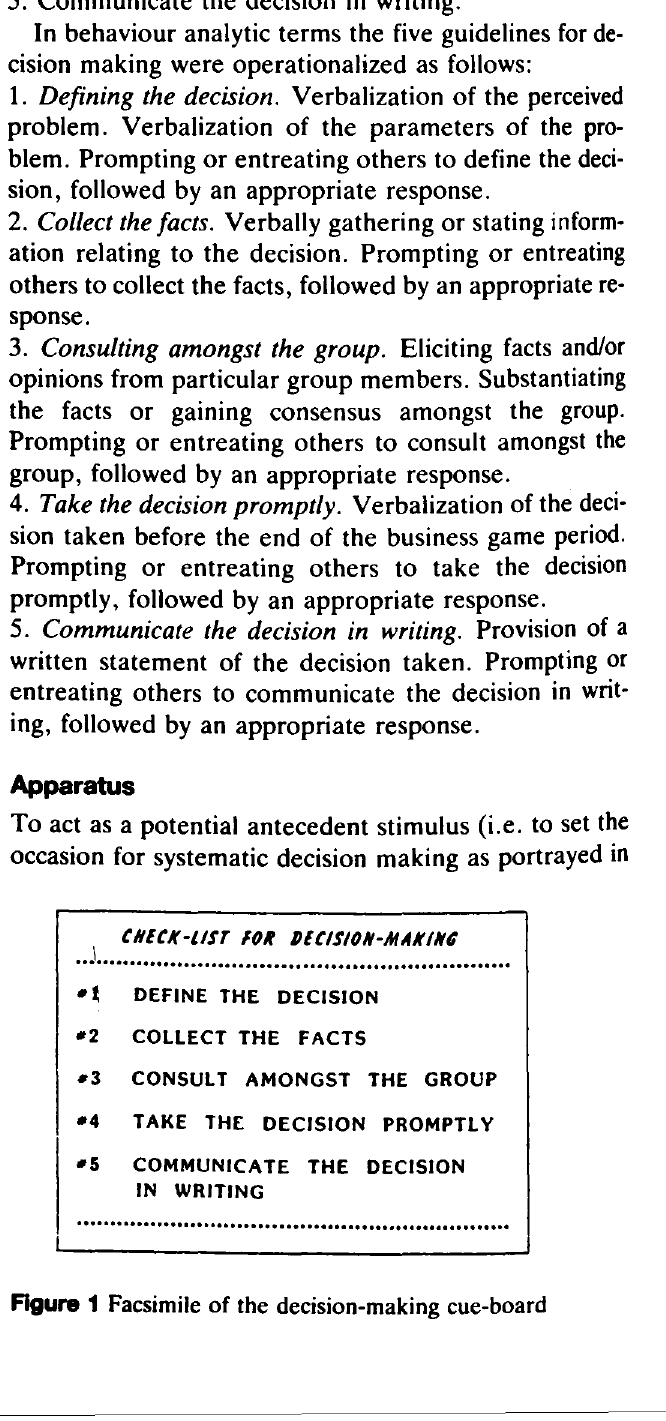
Figure 1 Facsimile of the decision-making